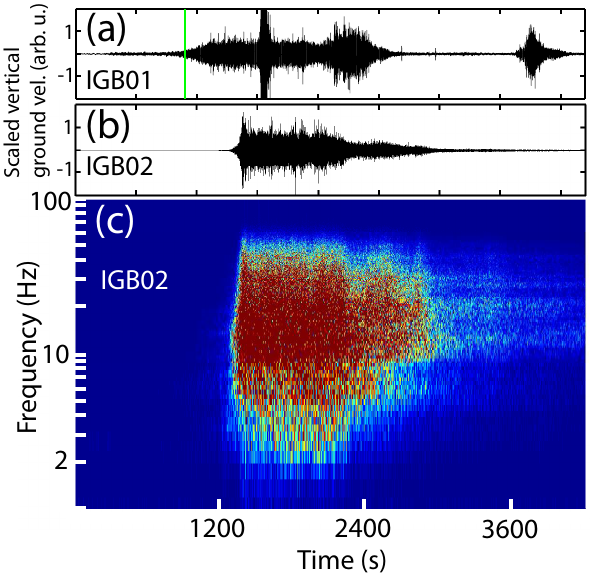
Figure 5. Debris-flow seismograms at stations IGB01 and IGB02 (a, b) and spectrogram of station IGB02 (c) . Green bar in (a) denotes 17:35 on 19 July 2011. Note the second seismic burst after 3600s likely represents a local mass motion event near IGB01. For illustration purposes, a bandpass filter between 0.01 and 50Hz has been applied to the time series (IGB01 and IGB02 are flat be- tween 1 and 100Hz and between 0.033 and 50Hz, respectively, as specified in Table